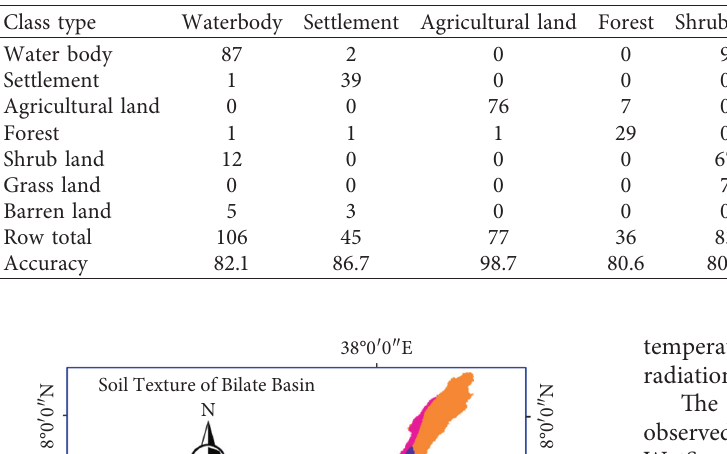
Table 5: Accuracy assessment of LULC